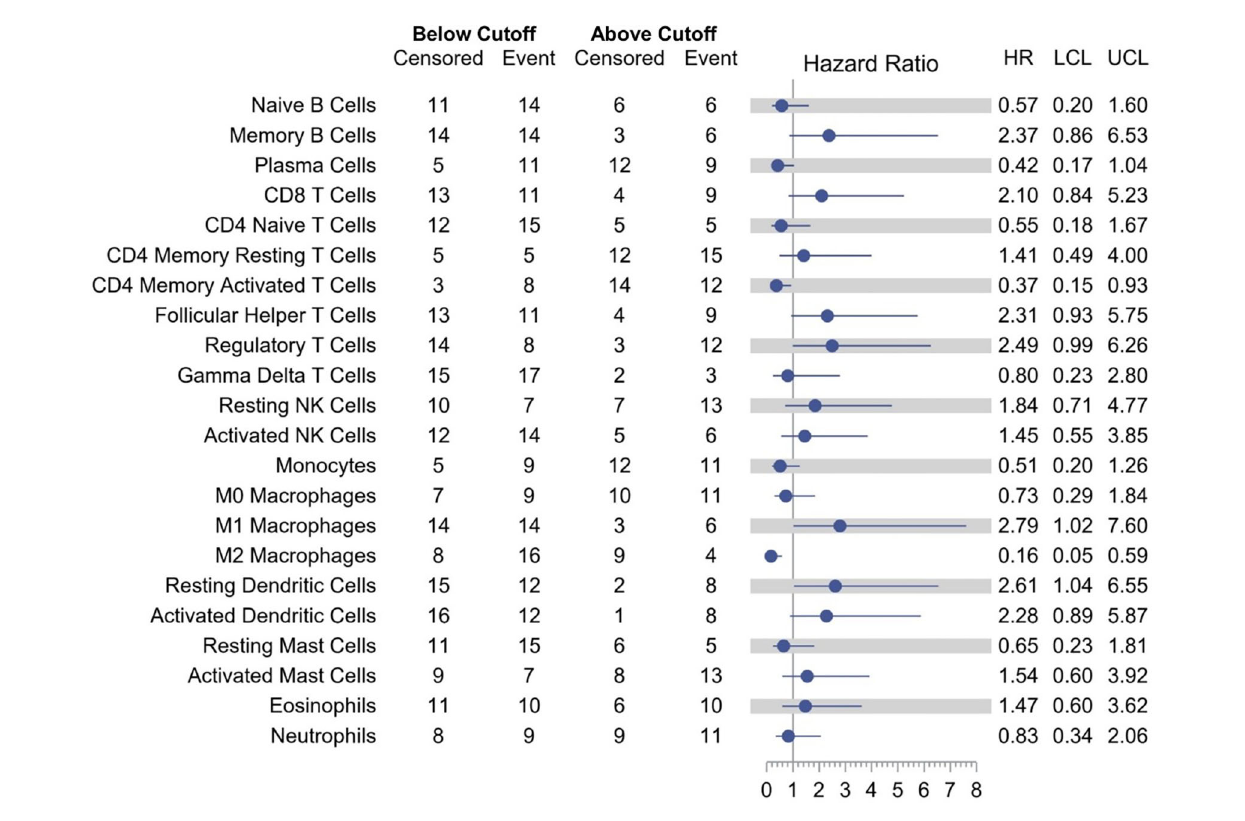
FIGURE 4 | Association of tumor immune cell population with